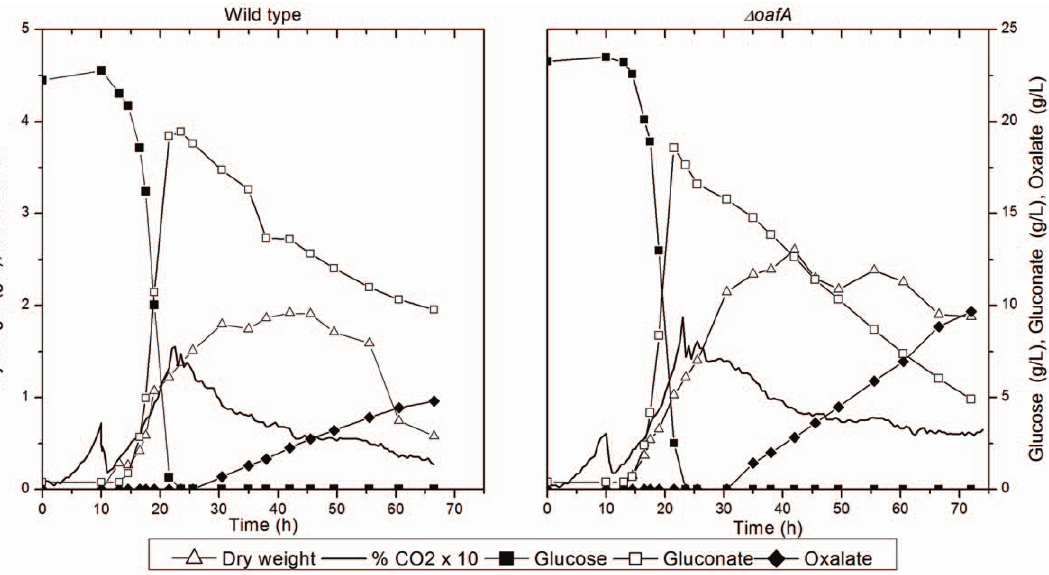
Figure 2. Representative profiles of the biomass concentration, sugar concentration, carbon dioxide formation and acid formation during batch cultivations at pH 6.0 with the WT-strain (left) and and the D oafA strain. The maximum specific growth rate was estimated trough a logarithmic plot of the biomass concentration as a function of time. Yield coefficients were calculated as overall yields based on the accumulated biomass or metabolite concentration in stationary phase related to the amount of consumed glucose. The volumetric oxalate formation rate was estimated as the slope of a linear regression of the oxalate titer as a function of time. doi:10.1371/journal.pone.0050596.g002 PLOS ONE |